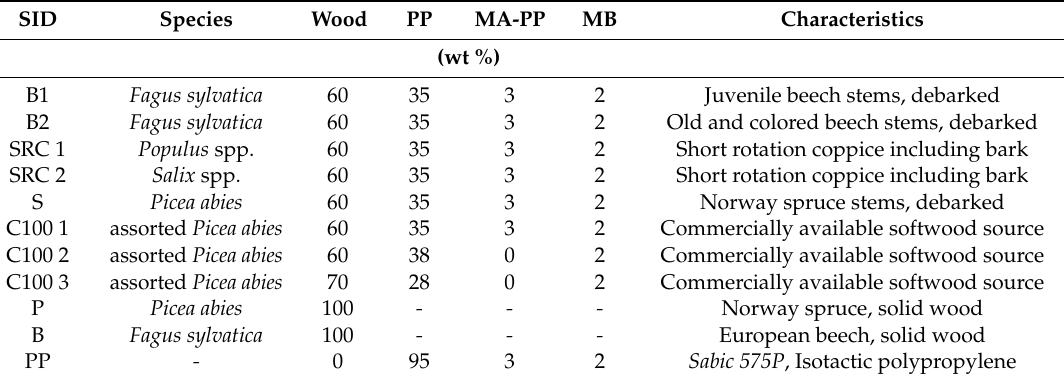
Table 1. Material composition of the wood–polypropylene (PP) composites and the polymer